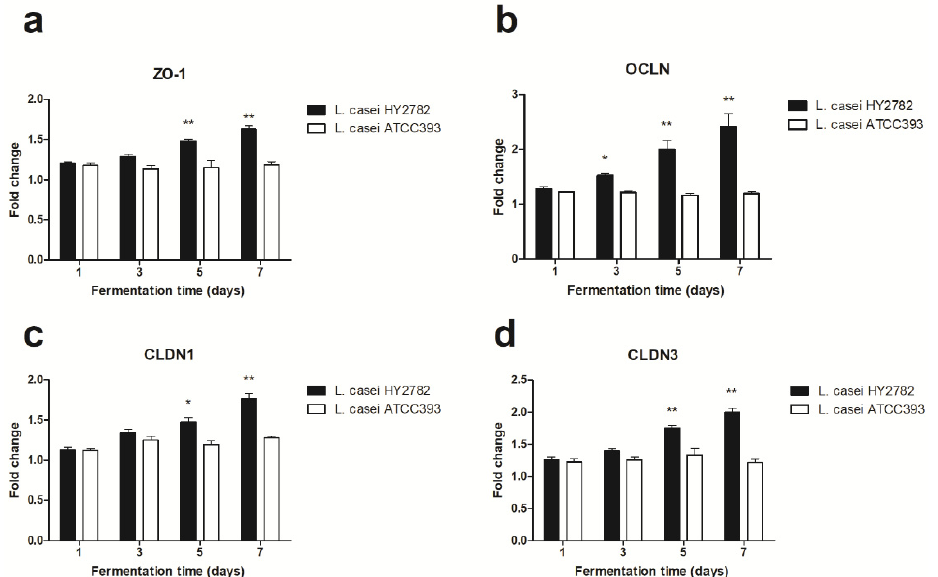
Figure 4. Relative mRNA levels of genes encoding the tight-junction proteins tight-junction protein 1 (ZO-1) ( a ), occludin (OCLN) ( b ), claudin 1 (CLDN1) ( c ), and CLDN3 ( d ) in Caco-2 cells after 10 h exposure to fermented milk with Lactobacillus casei HY2782 or L. casei ATCC393 versus fermentation time. Different letters above the bars indicate statistically significant differences from each sample on day 1 of fermentation (* p < 0.05, ** p < 0.01).